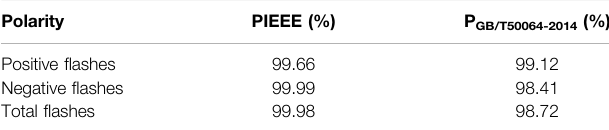
TABLE 3 | Correlation coef fi cients between measured values and calculated values by the IEEE and GB/T 50064-2014.